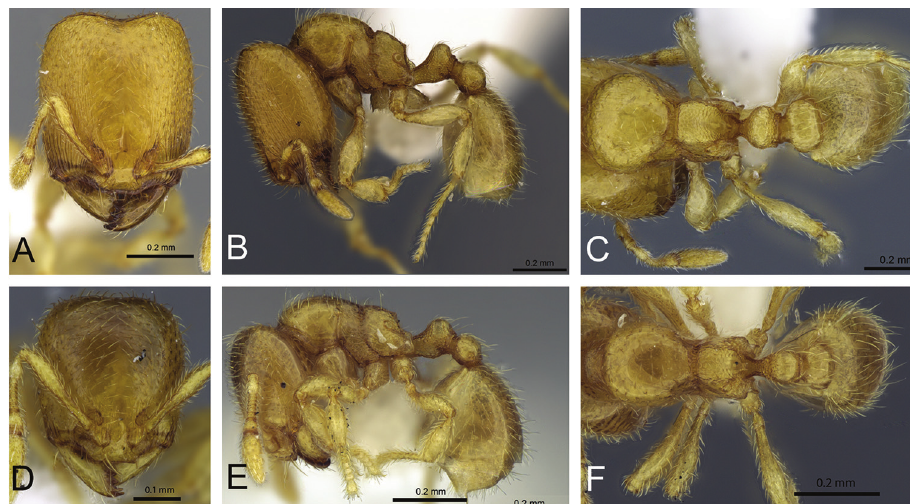
Figure 61. Carebara salegi –holotype. Major worker, CASENT0438150: A head in full-face view B body in profile view C body in dorsal view. Minor worker, CASENT0438115: D head in full-face view E body in profile view F body in dorsal